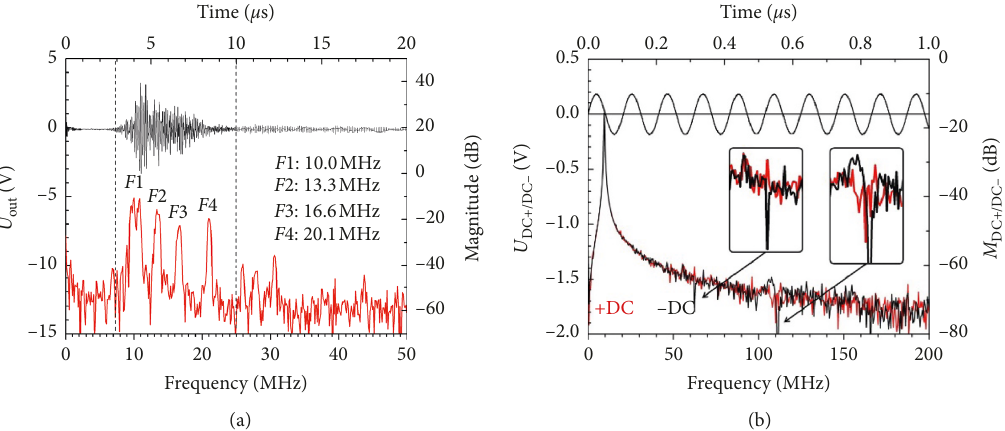
Figure 9: (a) The periodical structure formation response signal and spectra and (b) results of the interacted signal and spectra for the +DC (red curve) and DC (black curve), respectively. −